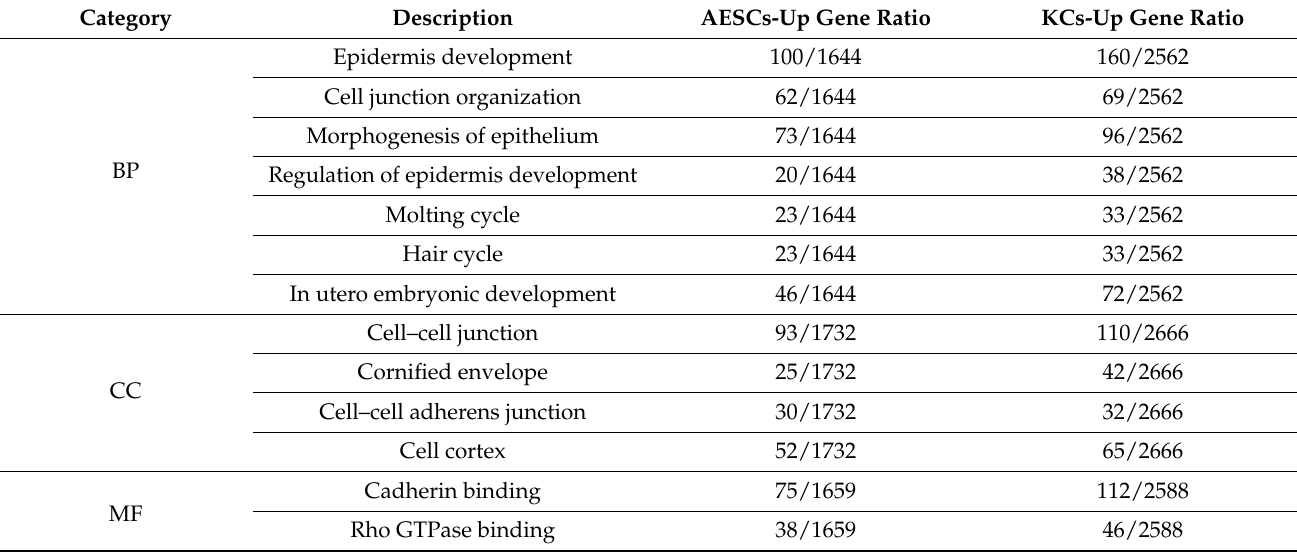
Table 1. Intersecting GO terms between AESCs and